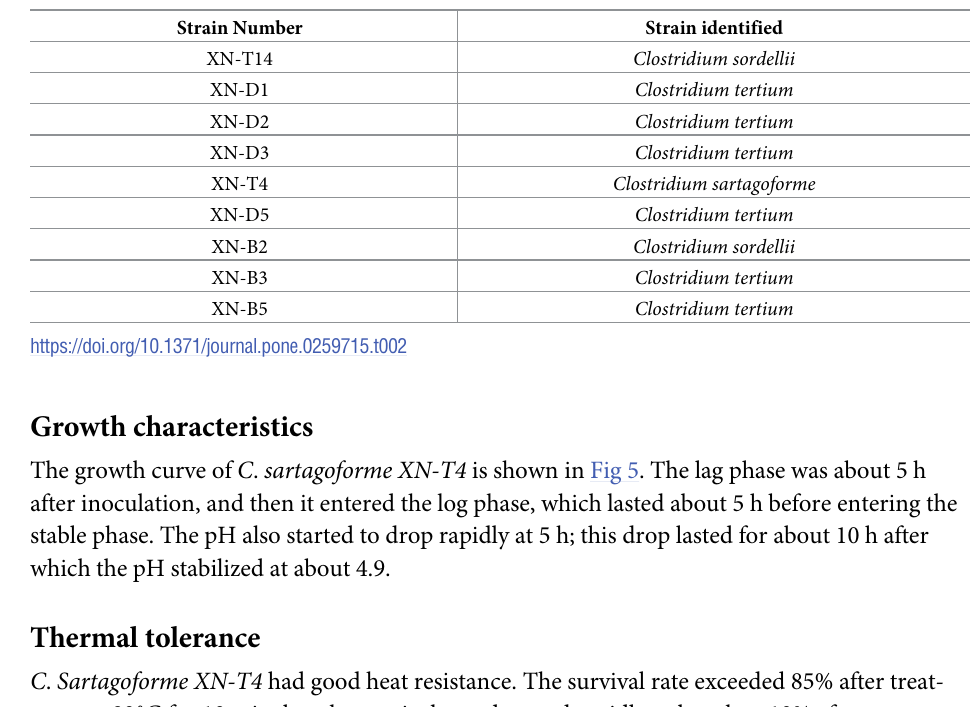
Table 2. Identification of the isolated